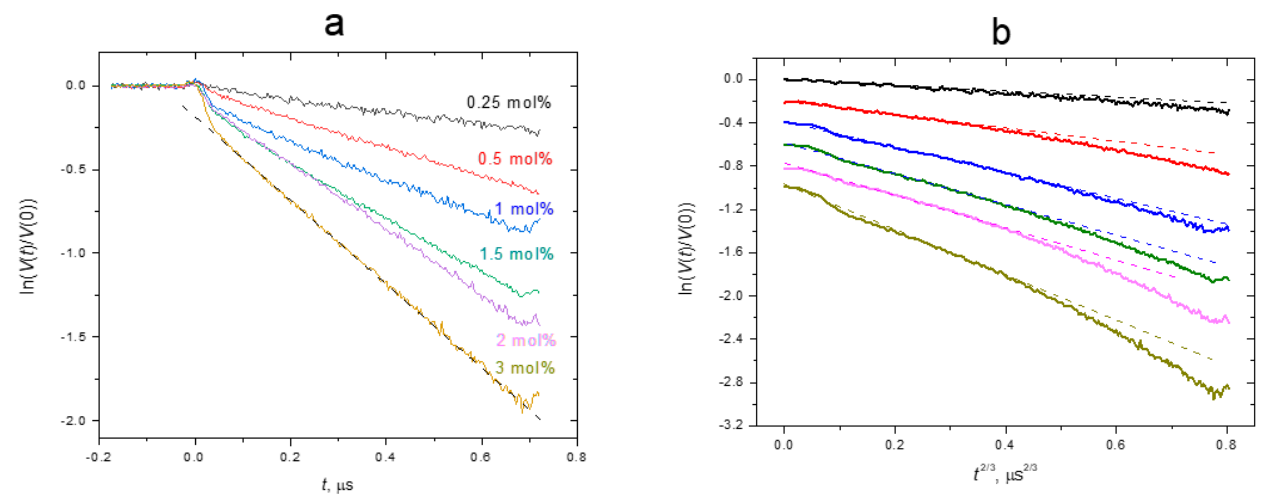
Figure 3. Semilogarithmic plot of three-pulse DEER time traces for ibuprofen-SL in the POPC bilayer taken for different molar concentrations χ . ( a ) The data are plotted vs. t . ( b ) The data are plotted vs. t 2/3 and shifted vertically for convenience. Straight dashed lines present linear approximations (see text).